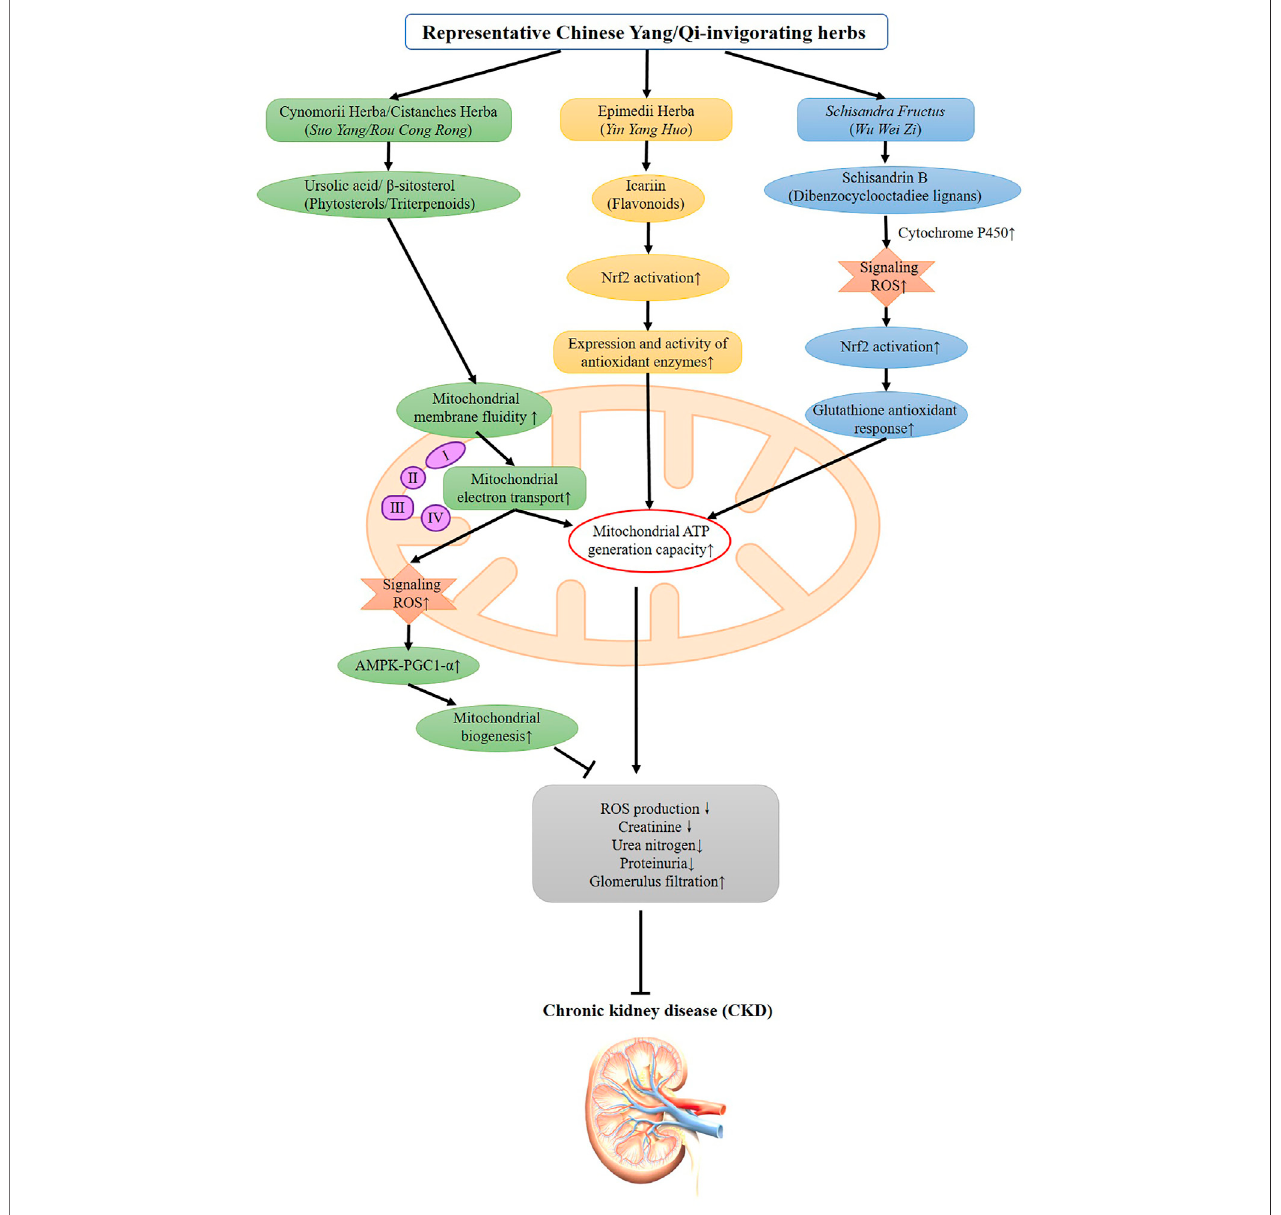
FIGURE 1 | Possible signaling pathways underlying the bene fi cial effects of representative Chinese Yang/Qi-invigorating herbs and their active ingredients on ameliorating CKD and its complications.